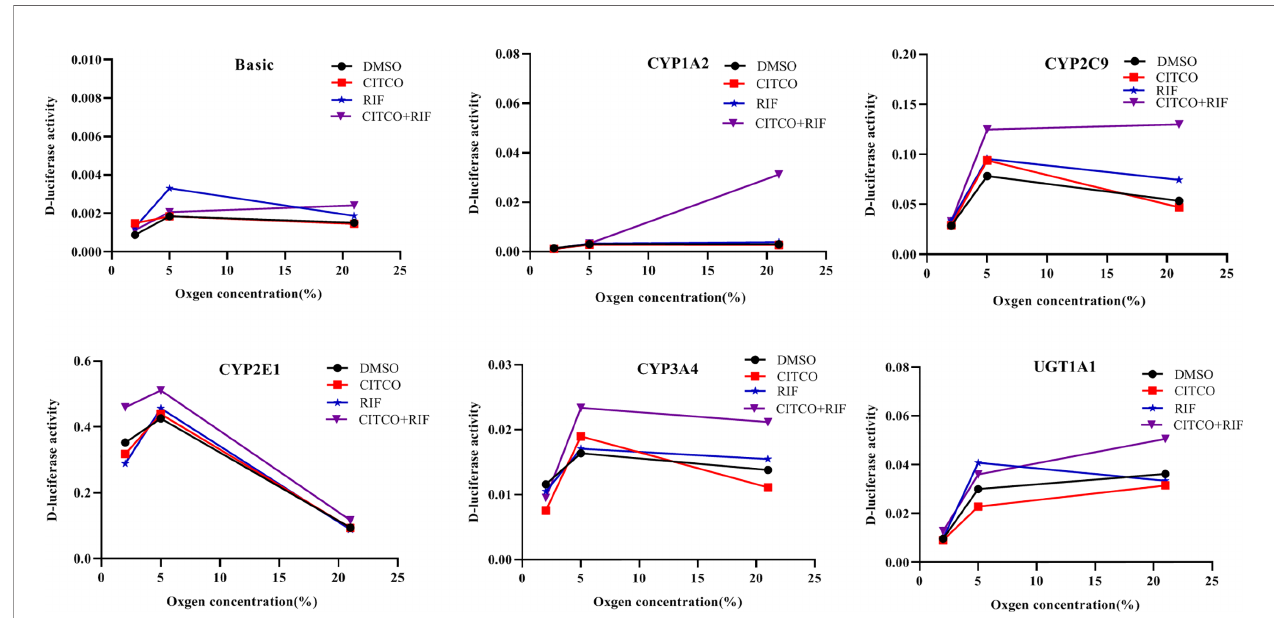
FIGURE 11 | The promoter activity of CYP1A2, CYP2C9, CYP2E1, CYP3A4, and UGT1A1 following agonist treatment under different oxygen concentrations. HepG2 cells were treated with RIF or CITCO under 2, 5, and 21% O 2 , after which the drug-containing medium was removed, and the D-luciferase activity of CYP450 and UGT1A1 were measured. n = 3 independent experiments in triplicate; a representative graph is shown. Rif (rifampicin): PXR agonist, CITCO (6- (4- chlorophenyl)-imidazo (2,1-b) thiazole-5-carbaldehyde): CAR